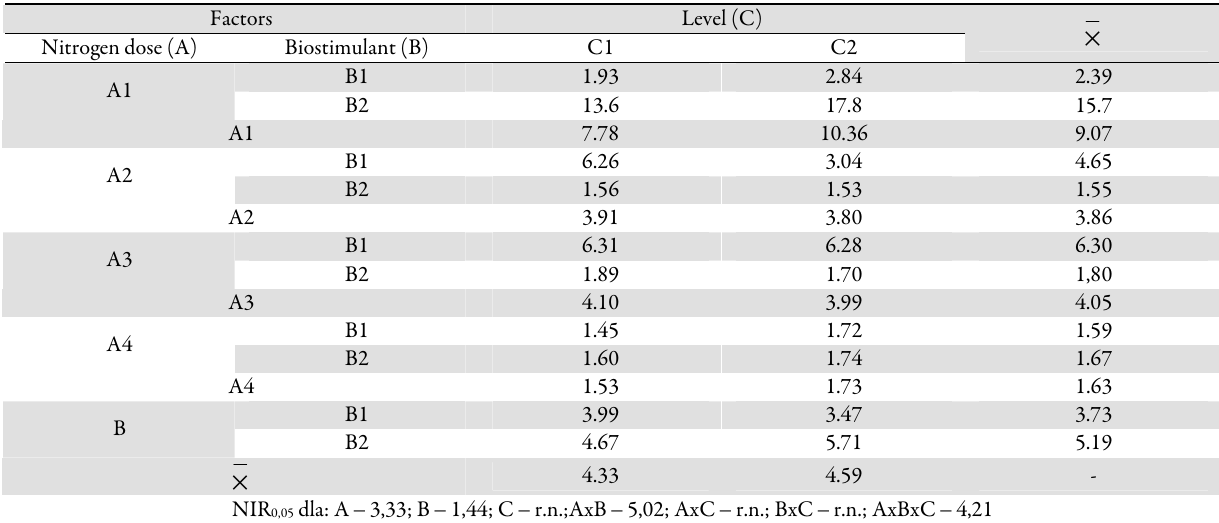
Tab. 5. The ratio of bacteria to fungi, depending on the nitrogen dose applied, biostimulant and soil